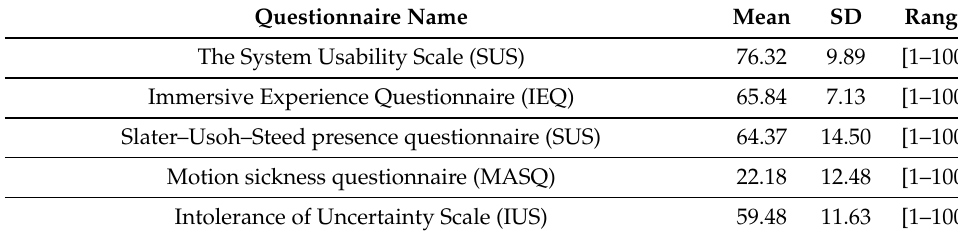
Table 6. Mean and standard deviation of scores received from participants’ answers to the question- naires.